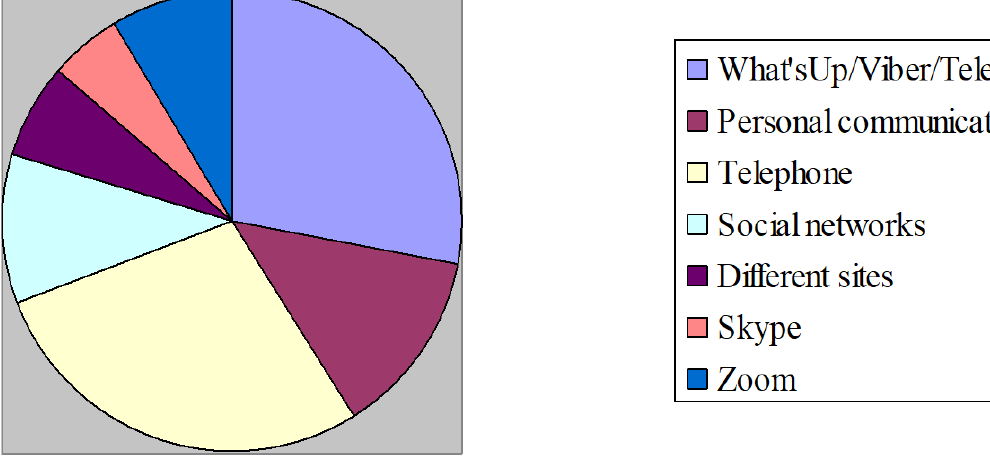
Figure 2 - The use frequency of different methods of communication in the South-West State University